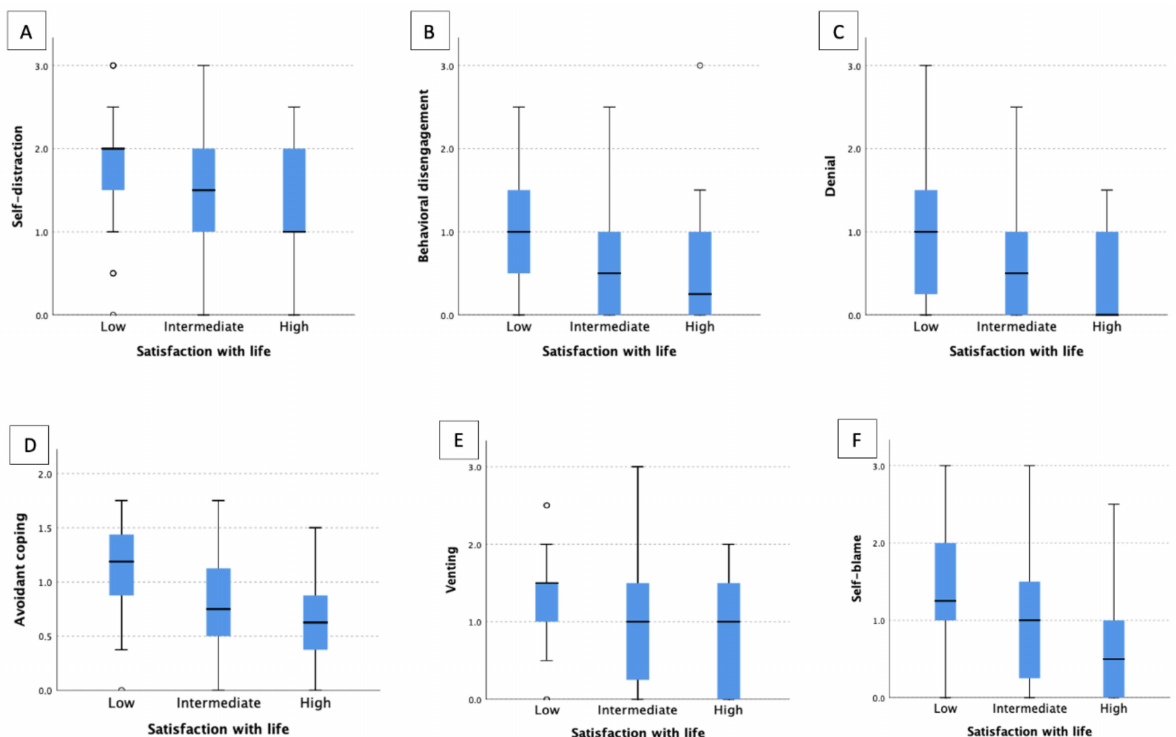
Figure 4. Coping strategies in HS patients with various satisfaction with life. ( A ) self-distraction/SWL; ( B ) behavioral disengagement/SWL; ( C ) denial/SWL; ( D ) avoidant coping/SWL; ( E ) venting/SWLl ( F ) self-blame/SWL. Each dot represents each patient’s questionnaire